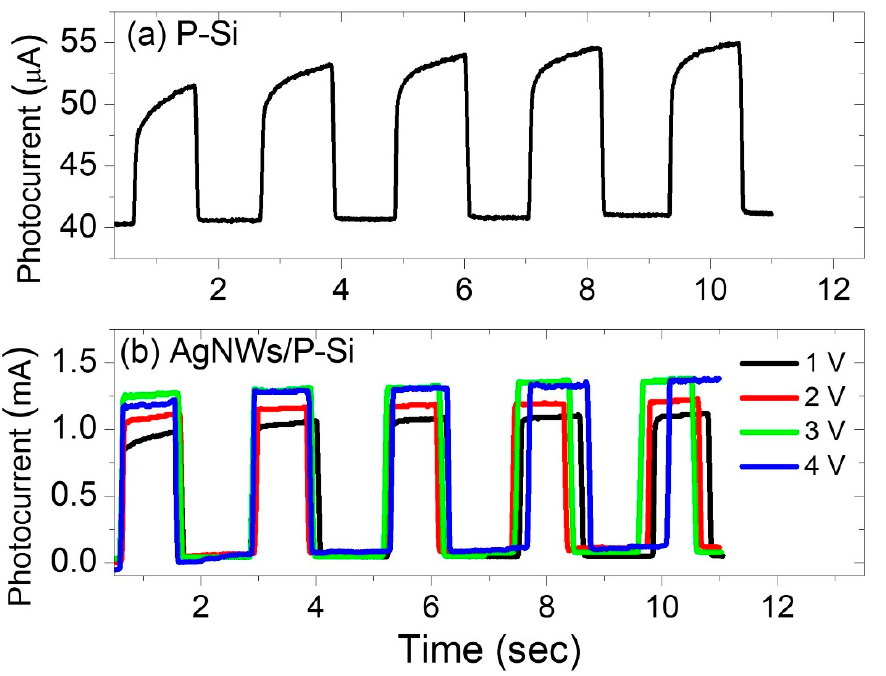
Figure 13. The photocurrent versus time of ( a ) porous Si and ( b ) AgNWs/porous Si photo-sensors for four bias voltages of 1V, 2V, 3V, and 4V.